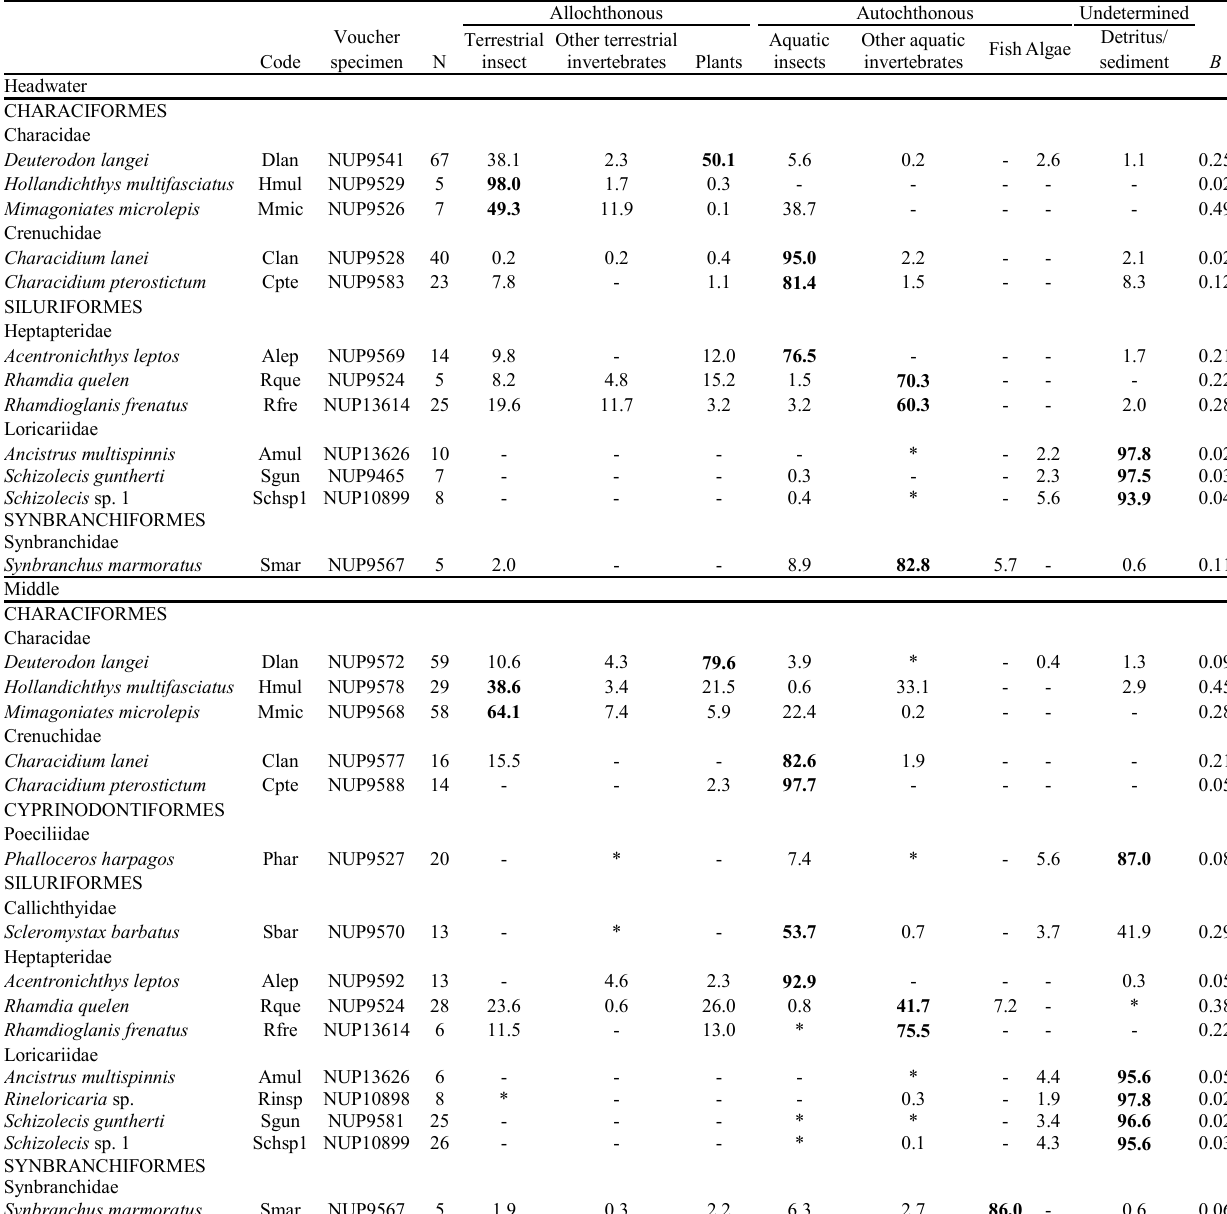
Table 3. Systematic position, diet composition and breadth (Levin’s index B ) of fish assemblage of the Vermelho River, East Atlantic basin, southern Brazil. Data are expressed as percentage volume of food items. Number of stomachs analyzed (N); * = Values < 0.1%; – not recorded. Predominant items are in